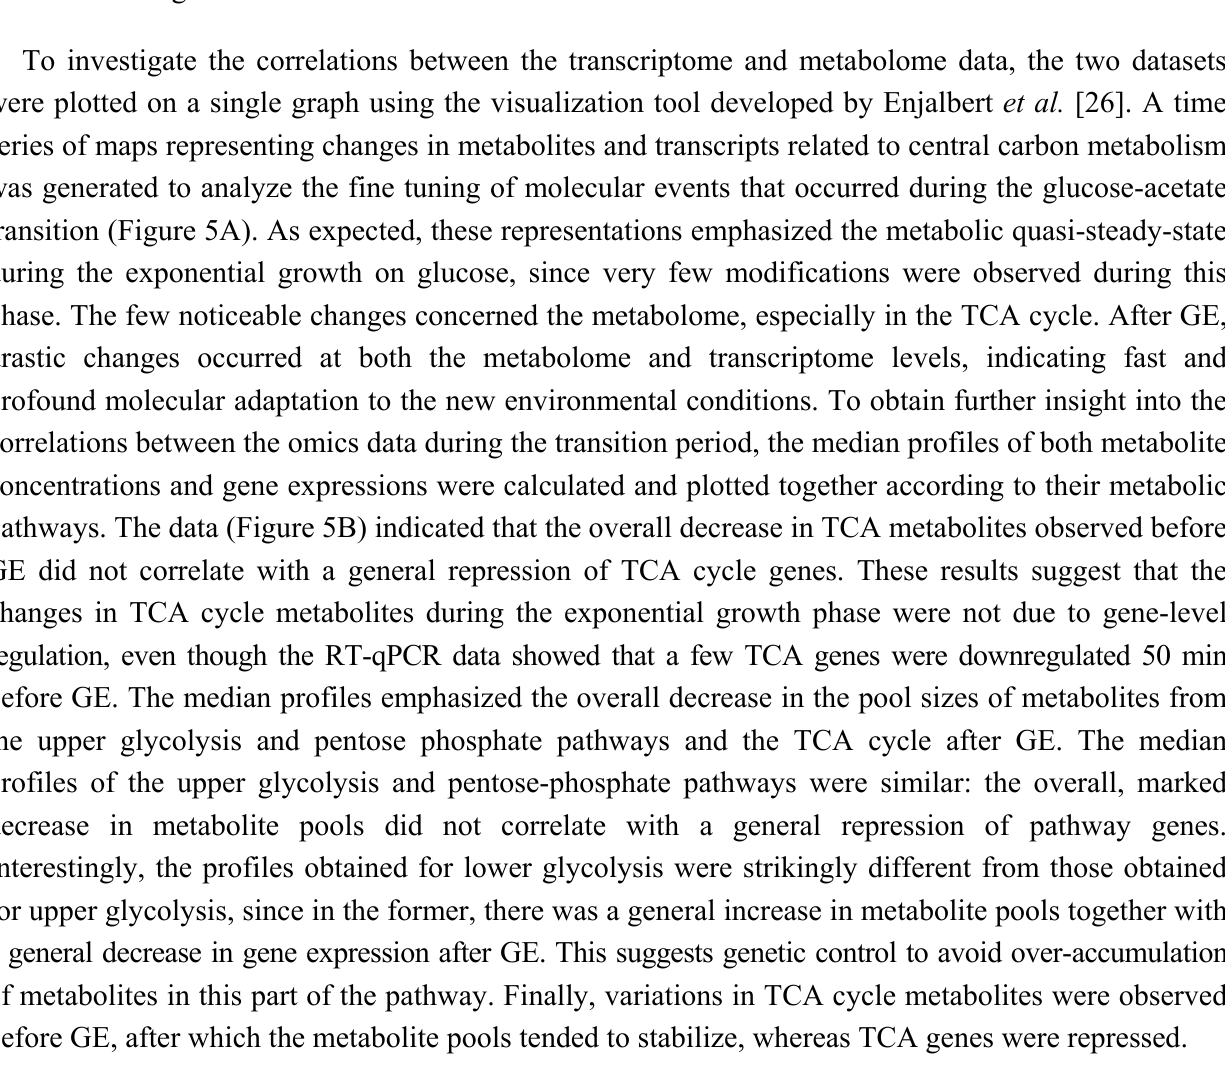
metabolic pathways. ( 5A ) Biochemical network used for the plotting of omics data. This map represents the set of metabolites (blue symbols) and genes (pink symbols) for which the data are plotted. ( 5B ) Changes in transcriptome and metabolome data during the